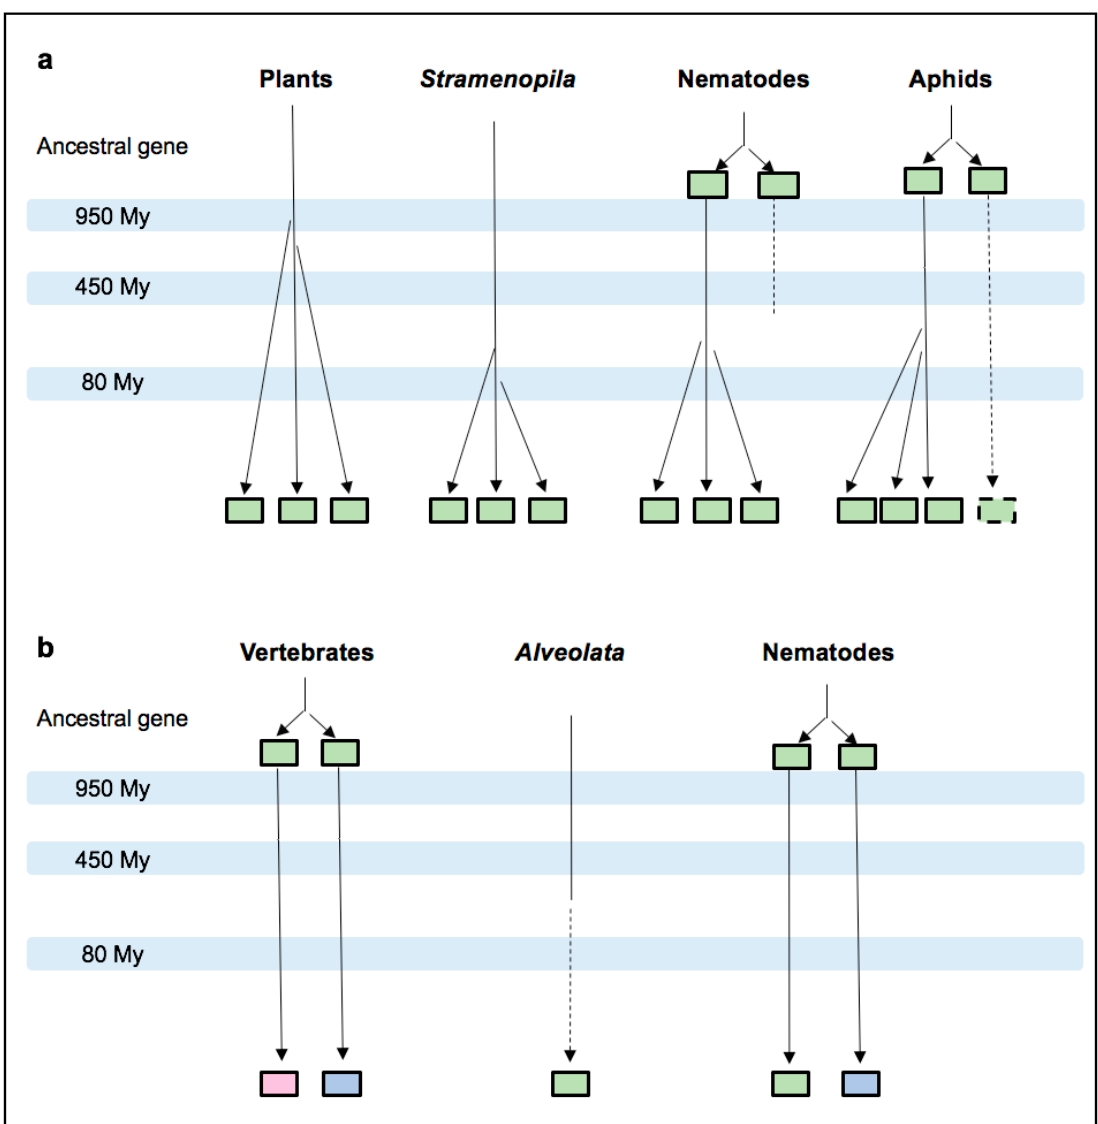
Figure 7. Evolutionary model showing MIF duplication events in phyla from selected eukaryotic kingdoms. The hypothesized duplication events are indicated on simplified lineage trees reconciling the median MIF number analysis and MIF phylogeny, for plants and plant parasites belonging to protists or metazoans ( a ), and for vertebrate and vertebrate parasites belonging to protists or metazoans ( b ). Light green boxes represent MIF members that cannot be related to the chordate MIF or D-DT variants in our study. Light pink and light blue boxes represent sequences associated with the chordate MIF and D-DT, respectively. Dashed lines indicate the apparent loss of one MIF member. The approximate time scale is based on median estimate from TimeTree. For example, 950 MYA represents the period between 757 and 1147 MYA.